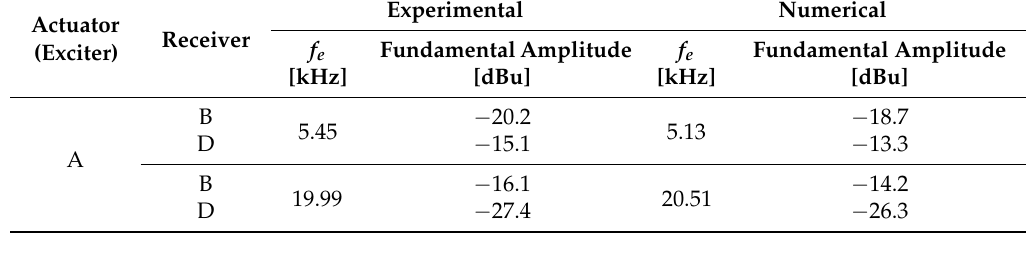
Table 3. Fundamental amplitude with f e equal to subharmonic frequencies.